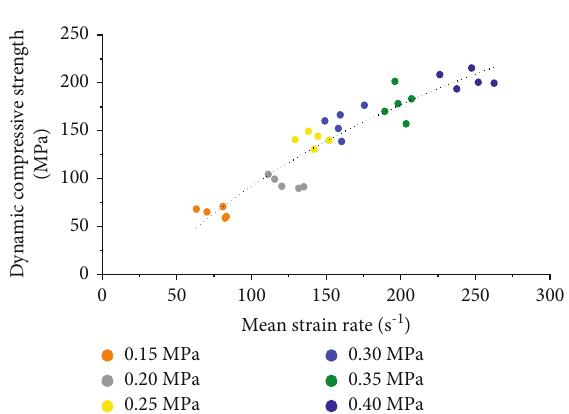
Figure 5: Relations between dynamic compressive strength and the average strain